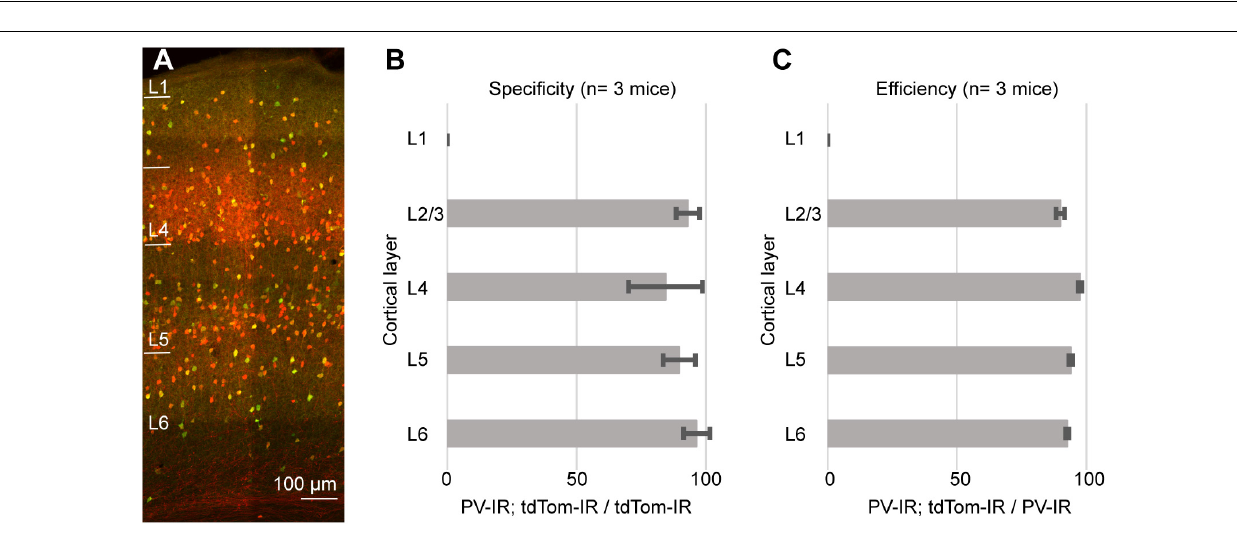
FIGURE 4 | (A) Representative confocal stack showing the overlap of immunofluorescence for PV (green) and tdTomato (Red) in barrel cortex. (B) Bar graph showing the specificity of the PV-IRES-Cre mouse line in barrel cortex in 3 animals. (C) Bar graph showing the efficiency of the PV-IRES-Cre mouse line in barrel cortex in 3